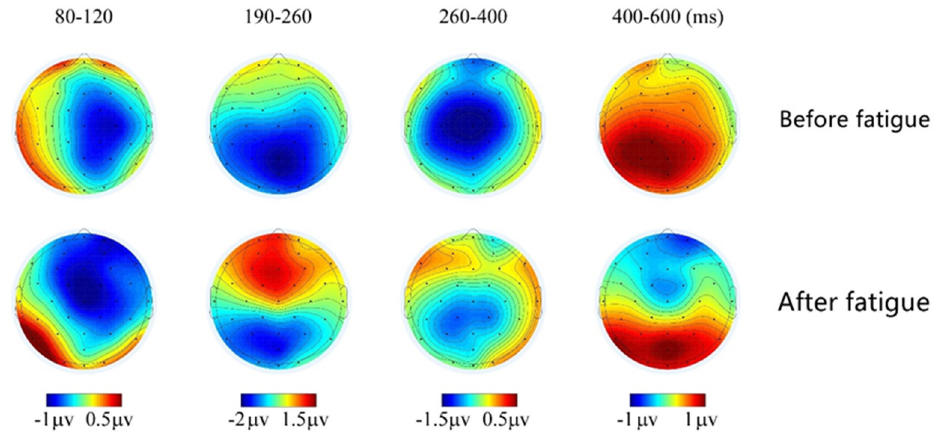
Figure 16. Brain topography at different time windows under deviant stimulation.